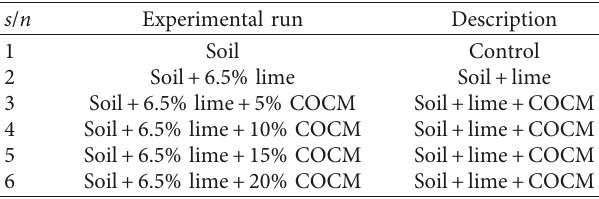
Table 1: Mixture ratios formulation of ingredients.